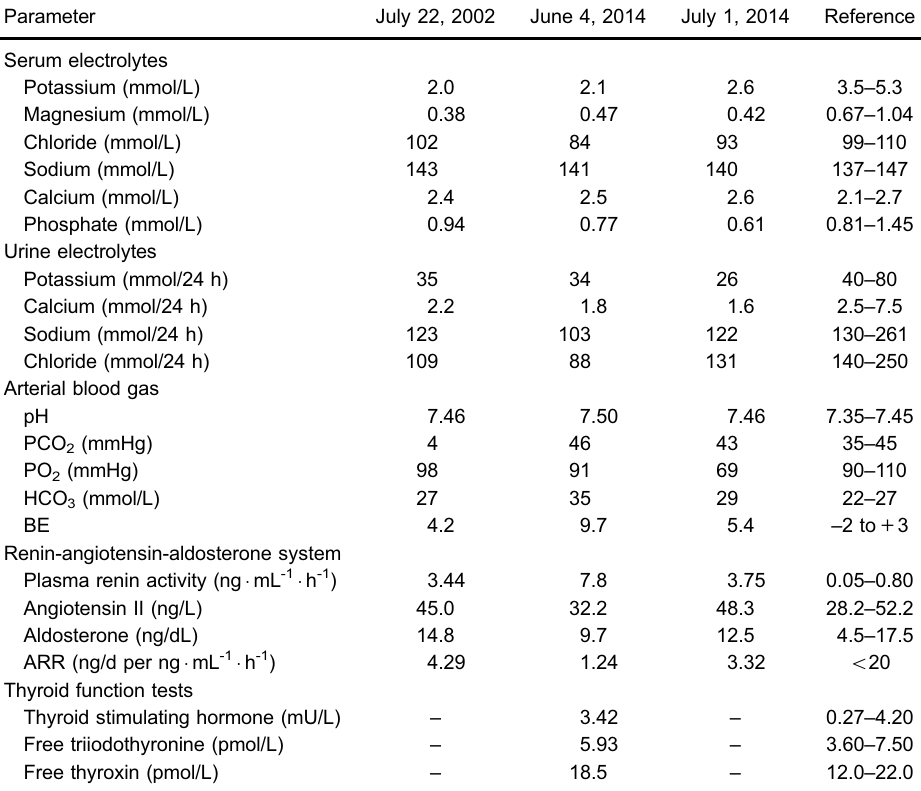
Table 1. Serial laboratory test results of a Gitelman syndrome patient (proband) at three different